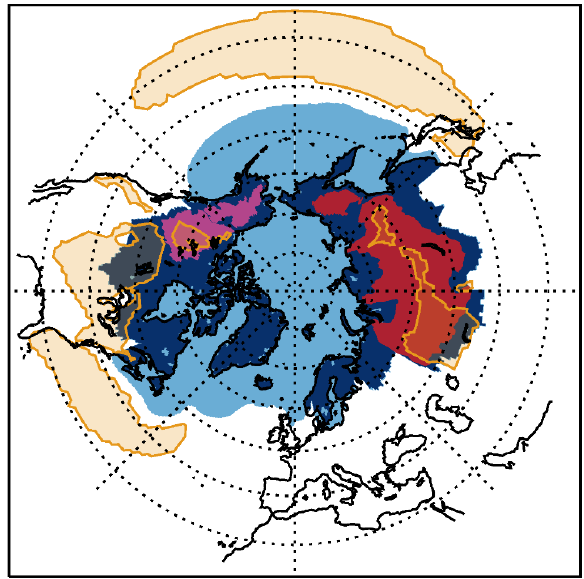
Figure 2. Main regions of study. The total solid colour-filled area (dark and light blue, red and pink) represents the Arctic domain as defined by Roberts et al. [42]. The red and pink regions represent the Eurasian and Canadian river basins respectively as considered in this study. Yellow contour areas represent the sources of moisture for the Arctic system used in the forward experiment developed by Vázquez et al. [47] in annual climatology from 1980–2012.